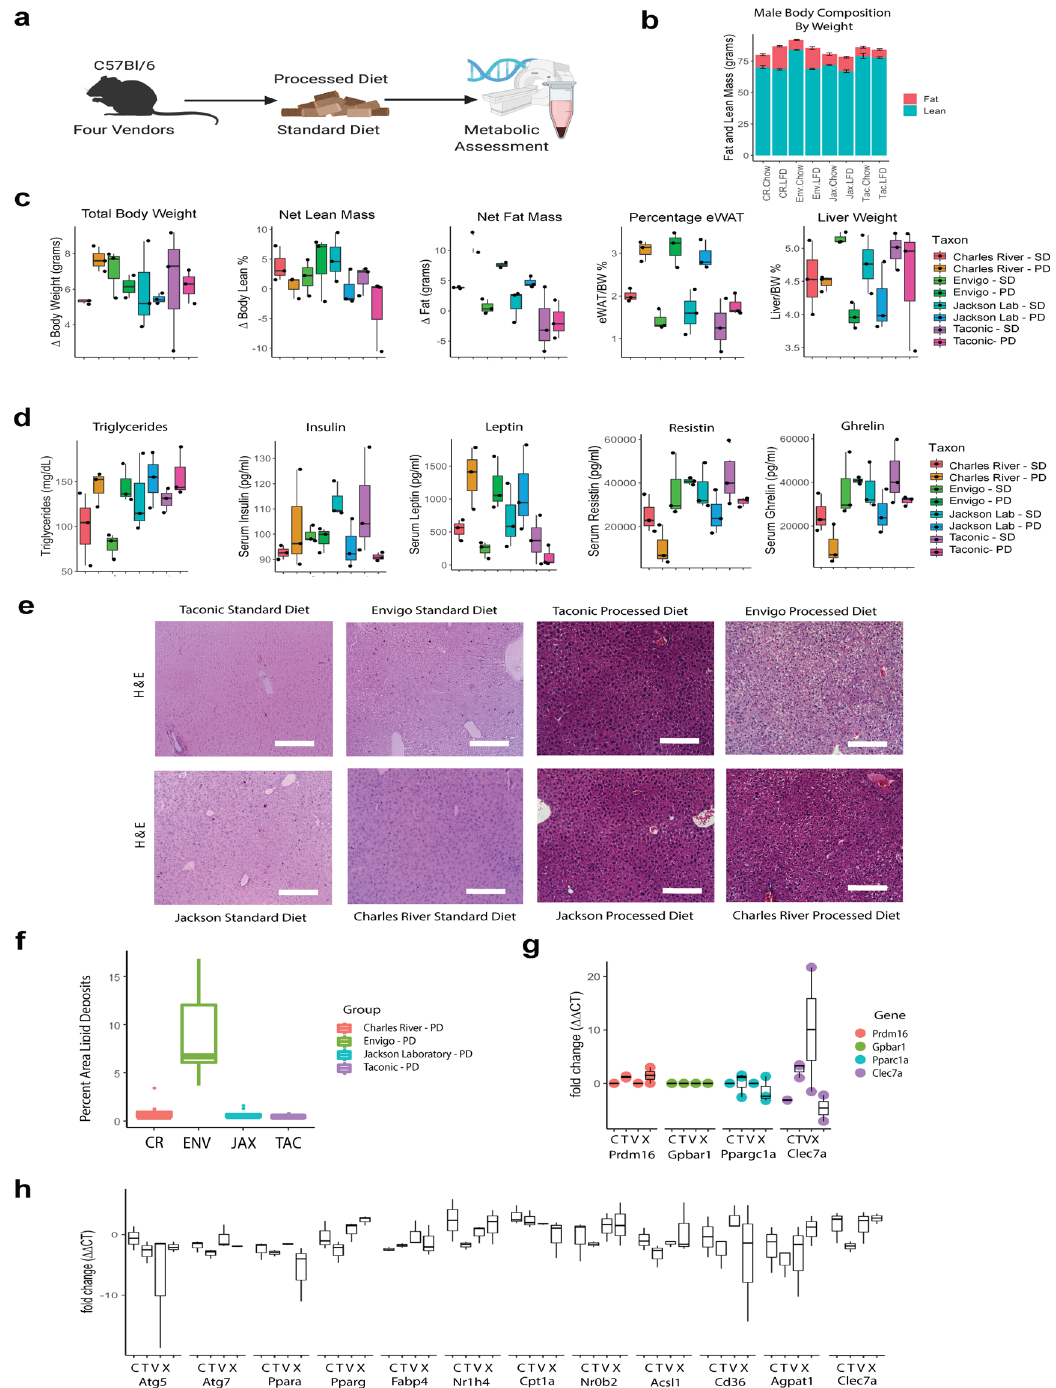
Fig. 6 The metabolic phenotype of male mice is sensitive to gut fungal community composition. a Experimental schematic. b Male mouse body composition by EchoMRI. c Male mouse body composition by tissue collection. d Male serum metabolically active biomarkers. e Hematoxylin and eosin- stained liver tissue show increased deposition after a processed diet, particularly in mice from Envigo. f Quanti fi cation of lipid deposition in males exposed to processed diet. g Gene expression in eWAT under processed diet. h Gene expression in liver. eWAT epididymal white adipose tissue, PD processed diet, SD standard diet. Schematic created using